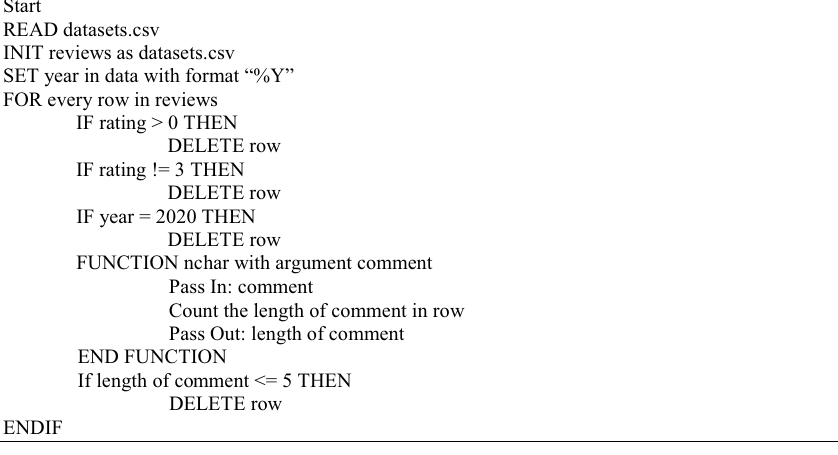
Table 1 Pseudocode to initiates the scripting environment, cleans the reviews dataset Start READ datasets.csv